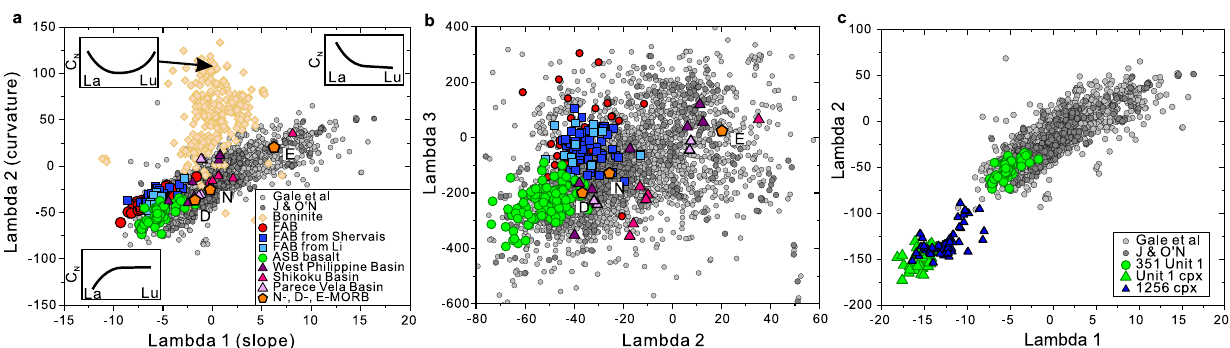
Fig. 6 Shape coef fi cients of rare earth element patterns 53 for comparison of Unit 1 ASB basalts with FAB, MORB/G, and backarc basin basalts of the Philippine Sea Plate. Data sources for a and b are Unit 1 26 , MORB from Gale et al. 28 and Jenner & O ’ Neill 56 , boninite 20,67,68 , FAB of Izu-Bonin- Mariana 11,54,55 and literature cited in ref. 19 . a Lambda 2 (curvature) versus lambda 1 (slope). Schematic chondrite-normalised REE abundance patterns characterised variously by light REE-depletion, enrichment and U-shaped patterns of boninite are shown in the corners of this plot. N-, D-, E-MORB represent normal MORB, depleted MORB, and enriched MORB. b Lambda 3 (sigmoidal character) versus lambda 2. c Lambda 2 versus lambda 1 comparing clinopyroxene from Unit 1 and gabbros at Site 1256 69 with ocean fl oor basalts 28,56 and Unit 1 bulk rock